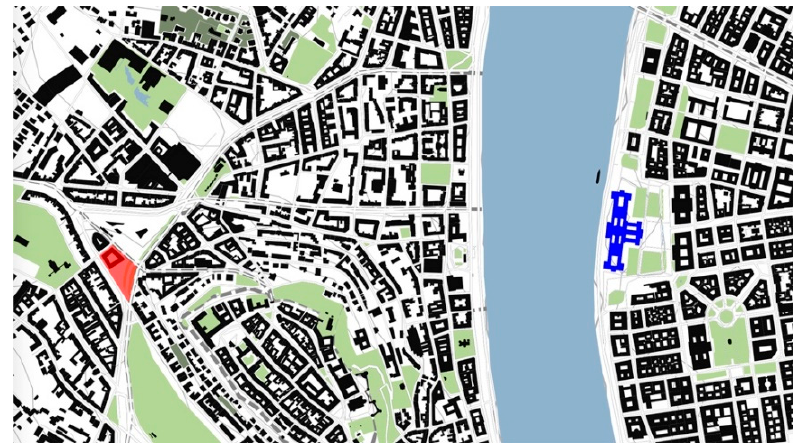
Figure 1. Urban context and the position of the Buda synagogue (red: the site of the synagogue, blue: Hungarian Parliament building). Source: swarzplan.eu and own editing. Arts 2019 , 8 , x FOR PEER REVIEW